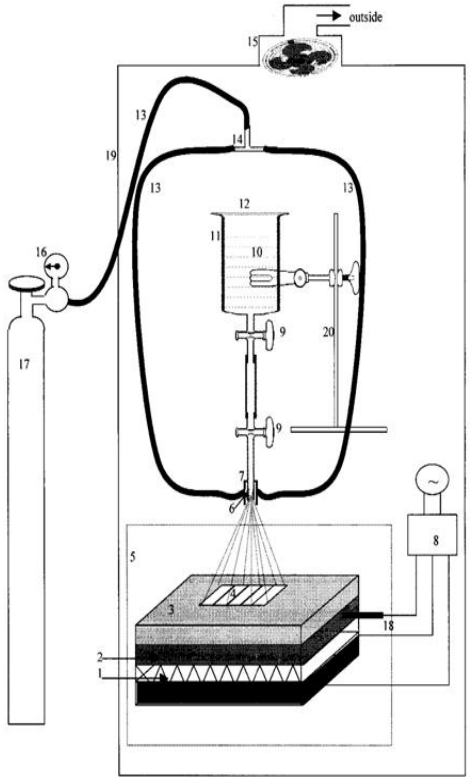
Figure 2. A schematic of the home-made spraying system. 1. Electrical Heater; 2. Copper Plate; 3. Aluminum Plate; 4. Substrates; 5. Insulation; 6. Spraying Nozzle; 7. Bulb of PVC; 8. Temperature Controller; 9. Stopcocks; 10. Solution; 11. Glass Dewar; 12. Cover; 13. Rubber Tubes; 14. T-Connector; 15. Fan; 16. Regulator; 17. Nitrogen Cylinder; 18. Thermocouple; 19. Fume-Hood; 20.